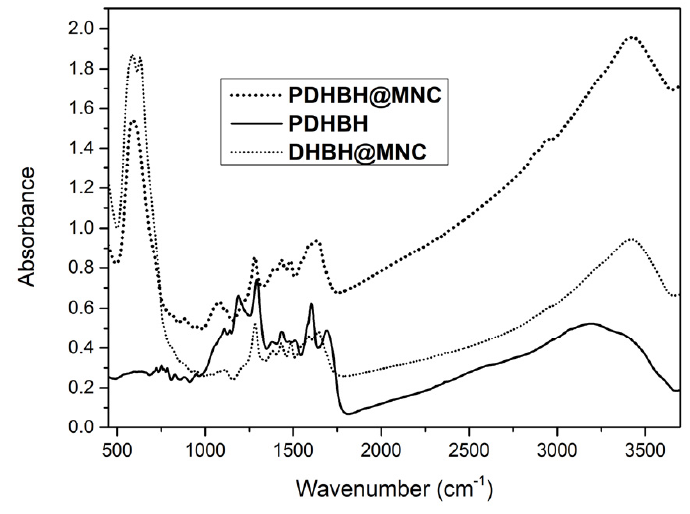
Figure 3. FT-IR spectra of PDHBH, PDHBH@MNC and DHBH@MNC.